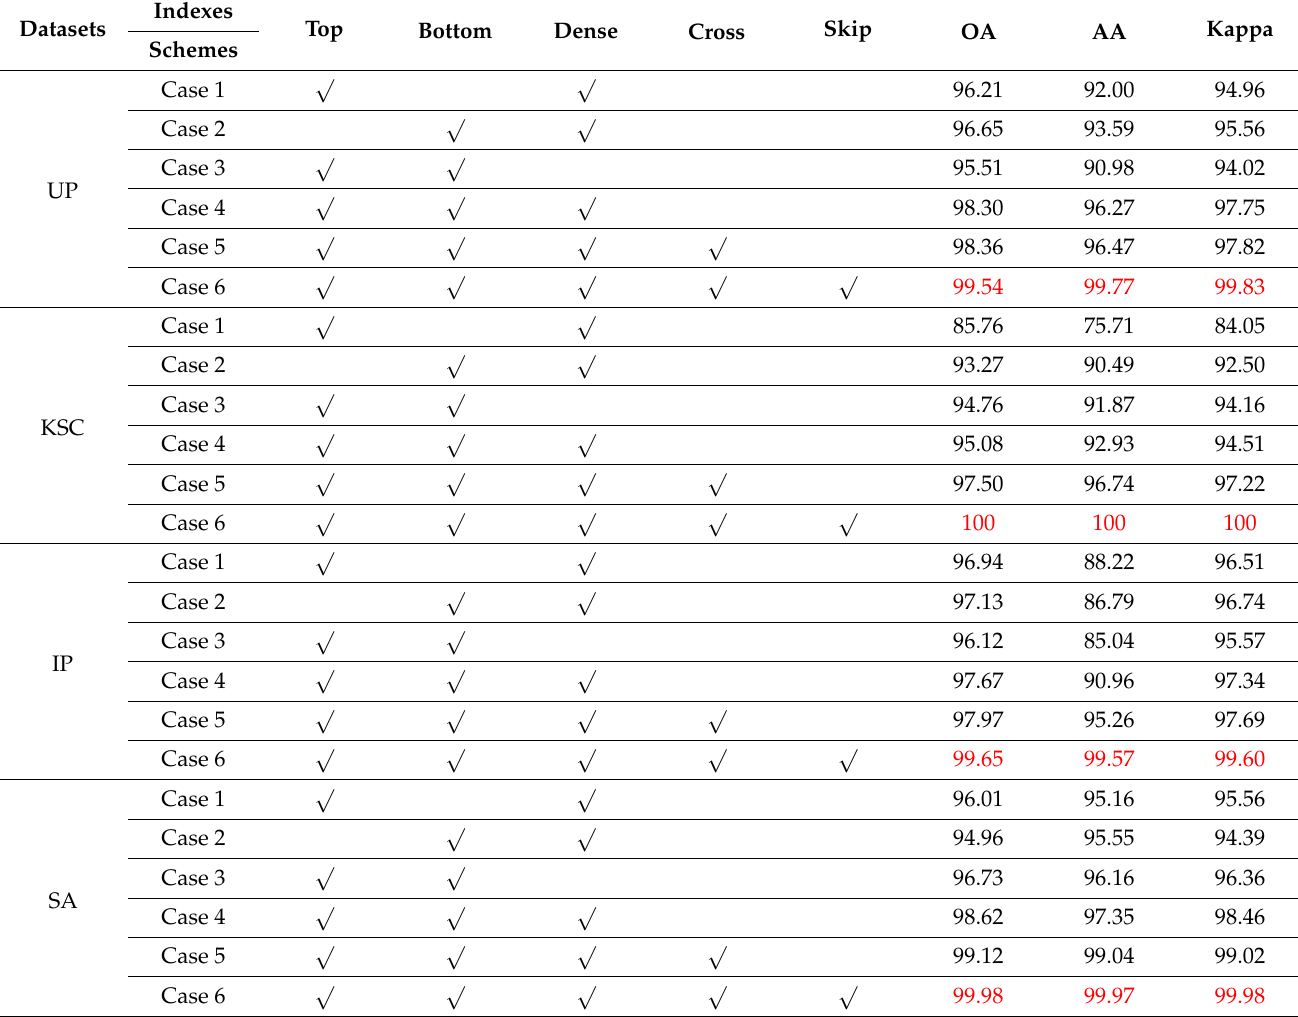
Table 9. Classification results of the SFEB with different building blocks on four public